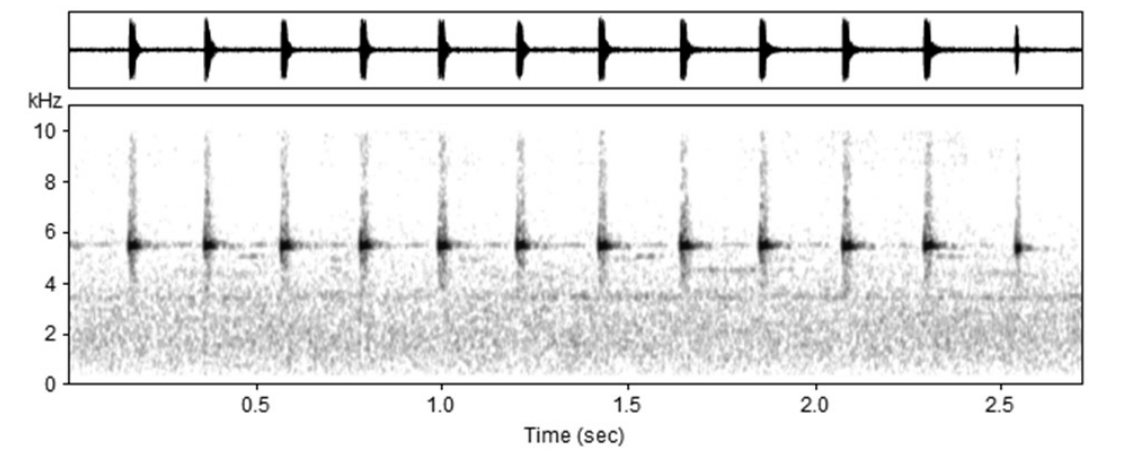
Figure 3. Wave form (above) and spectrogram (below) of an advertisement call from Choerophryne crucifer with 12